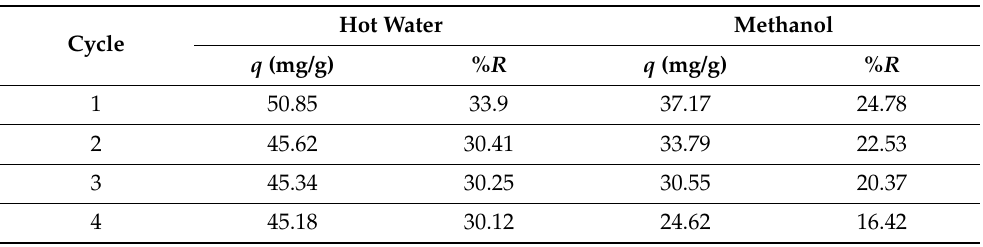
Figure 16. Regeneration and reusability of IL–agar–alginate beads. Table 5. Regeneration of phenol loaded IL–agar–alginate beads by hot water and hot methanol both at a temperature of 50 ◦